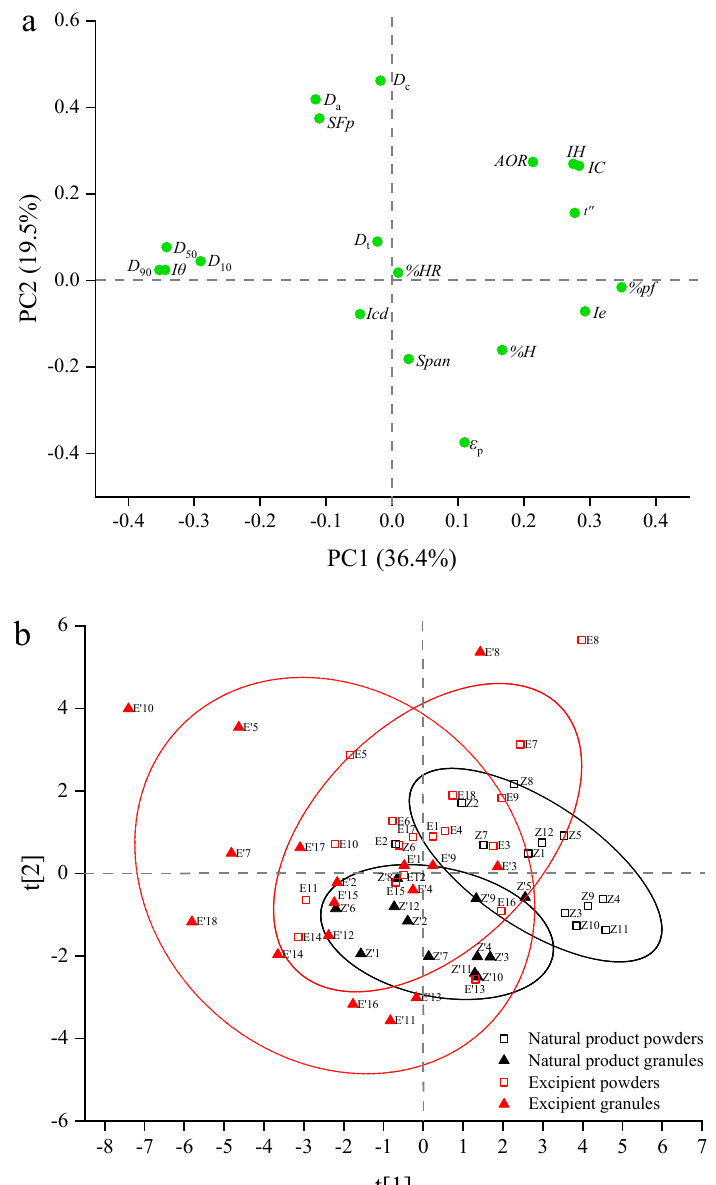
Figure 3. The PCA analysis for the physical properties data base on the first two principal components. ( a ) the loading plot; ( b ) the score plot. (The black squares represent NPPs. The black triangles represent NPGs. The red squares represent excipient powders. The red triangles represent excipient granules. Two black circles are 95% confidence ellipses for NPPs and NPGs, respectively. Two red circles are 95% confidence ellipses for excipient powders and excipient granules, respectively).